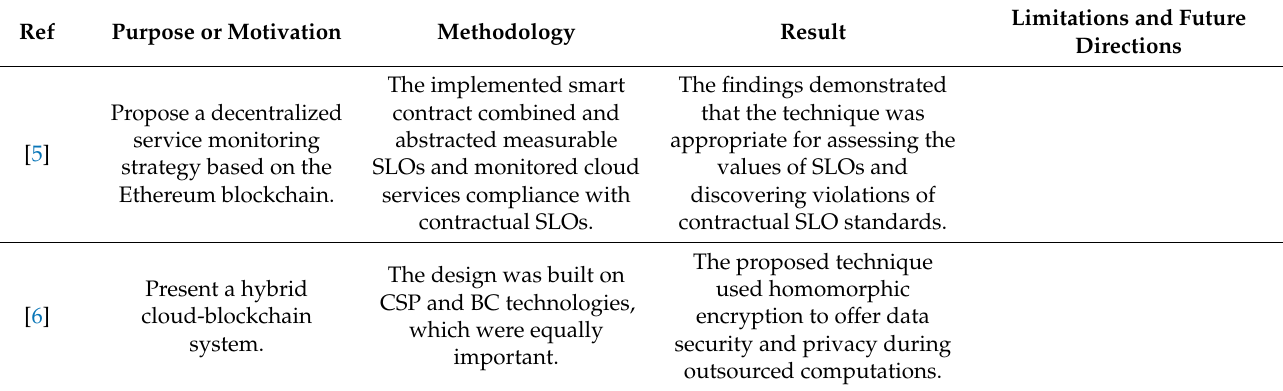
Table 1. Summary of related